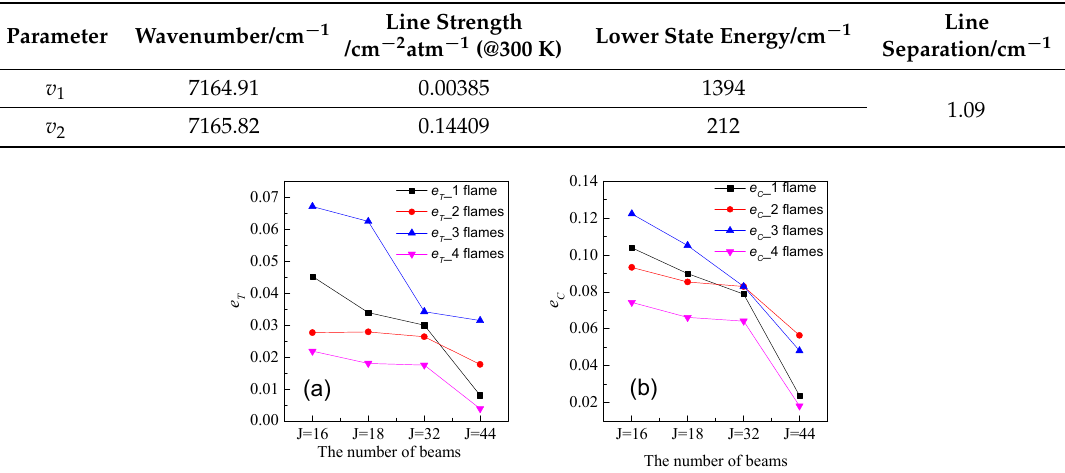
Table 1. The selected absorption transition spectral parameters. Table 1 . The selected absorption transition spectral parameters.